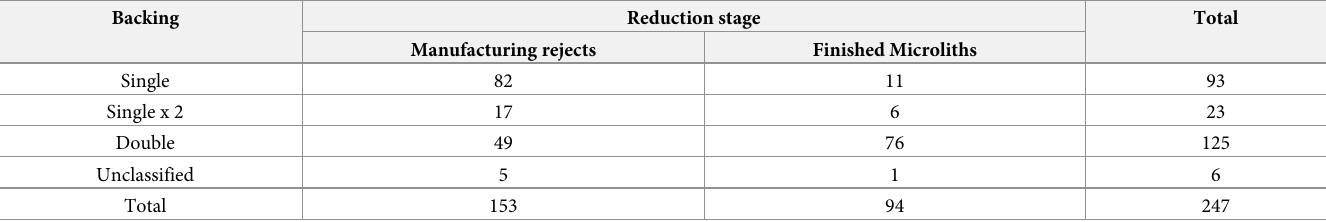
Table 7. Single- and double-backed edges relative to microlith reduction stages, Horizon IV, Saruq al-Hadid. Backing Reduction stage Total Finished